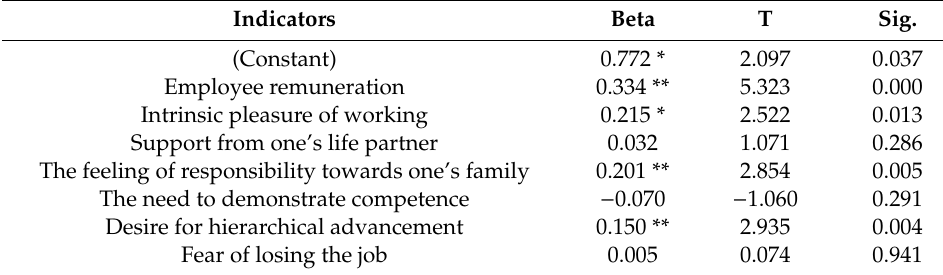
Table 5. The independent variables’ impact on the description of workaholism in the IT industry.